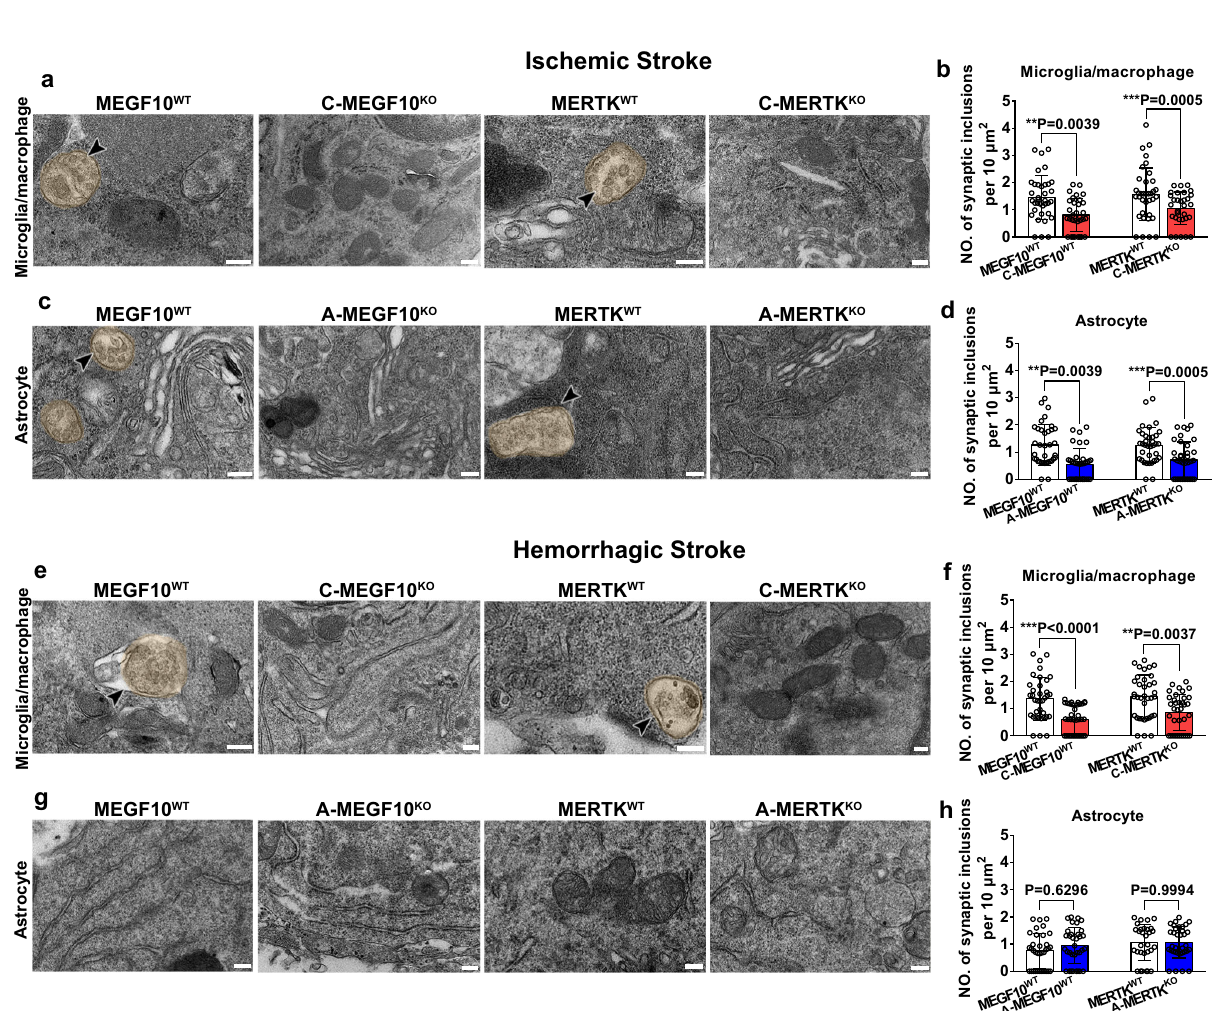
Fig. 6 Conditional MEGF10 or MERTK knockout reduced glial cell-mediated synapse engulfment after stroke. a – d TEM images showed Iba-1 + microglia/macrophages and GFAP + astrocytes in the gliosis region enwrapped engulfed synaptic elements in MEGF10 WT and MERTK WT mice, but the number of engulfed synaptic elements were reduced in C-MEGF10 KO , C-MERTK KO , A-MEGF10 KO , and A-MERTK KO mice after ischemic stroke. Arrowheads indicate synaptic elements that were engulfed by microglia/macrophages ( a , b ) or astrocytes ( c , d ). Statistics are derived from 36, 32, 36, 31 cells ( b ) and 36, 36, 36, 36 cells ( d ) (from left to right), n = 3 mice per group. e – h TEM images showed Iba-1 + microglia/macrophages in the gliosis region contained synaptic elements in MEGF10 WT and MERTK WT mice ( e , f ); while synaptic elements were rarely detected in GFAP + astrocytes ( g , h ). Statistics are derived from 36, 36, 36, 36 cells ( f ) and 34, 34, 30, 34 cells ( h ) (from left to right), n = 3 mice per group. Bar = 200 nm. One-way ANOVA followed by Tukey ’ s test. Data are mean ±